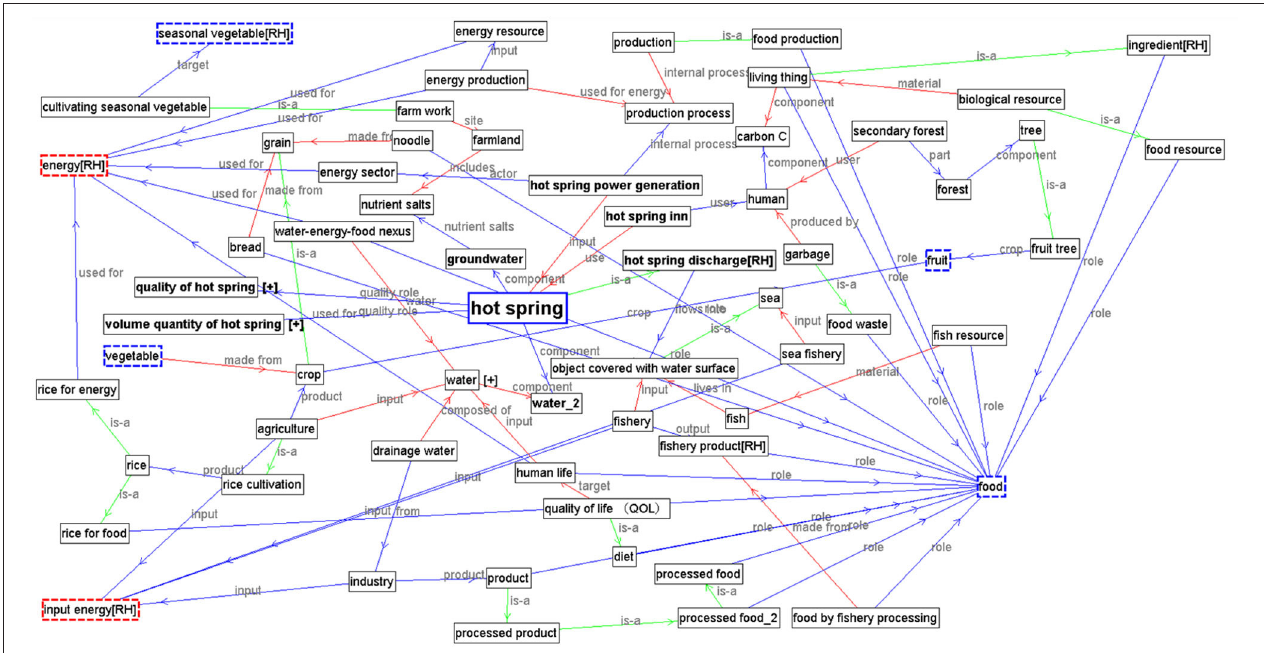
FIGURE 6 | The “hot spring”-water-energy-food nexus system map centering on the concept of “hot